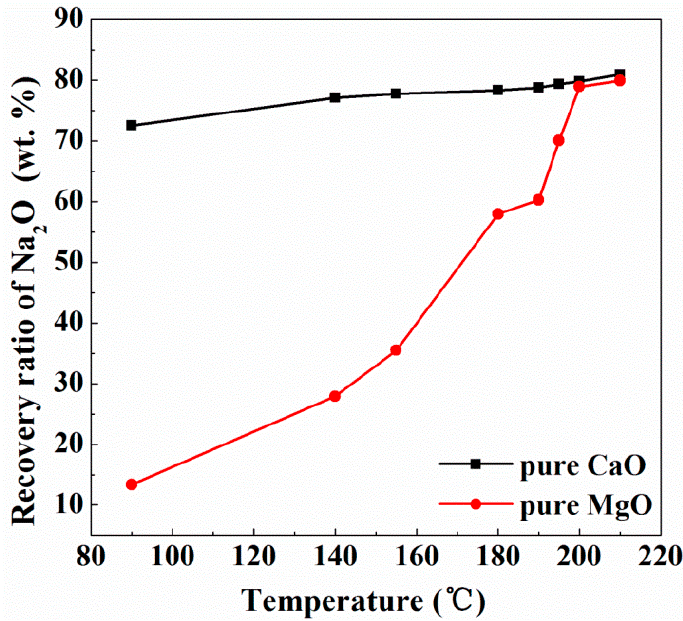
/ MgO ( t = 3 2 O using pure CaO